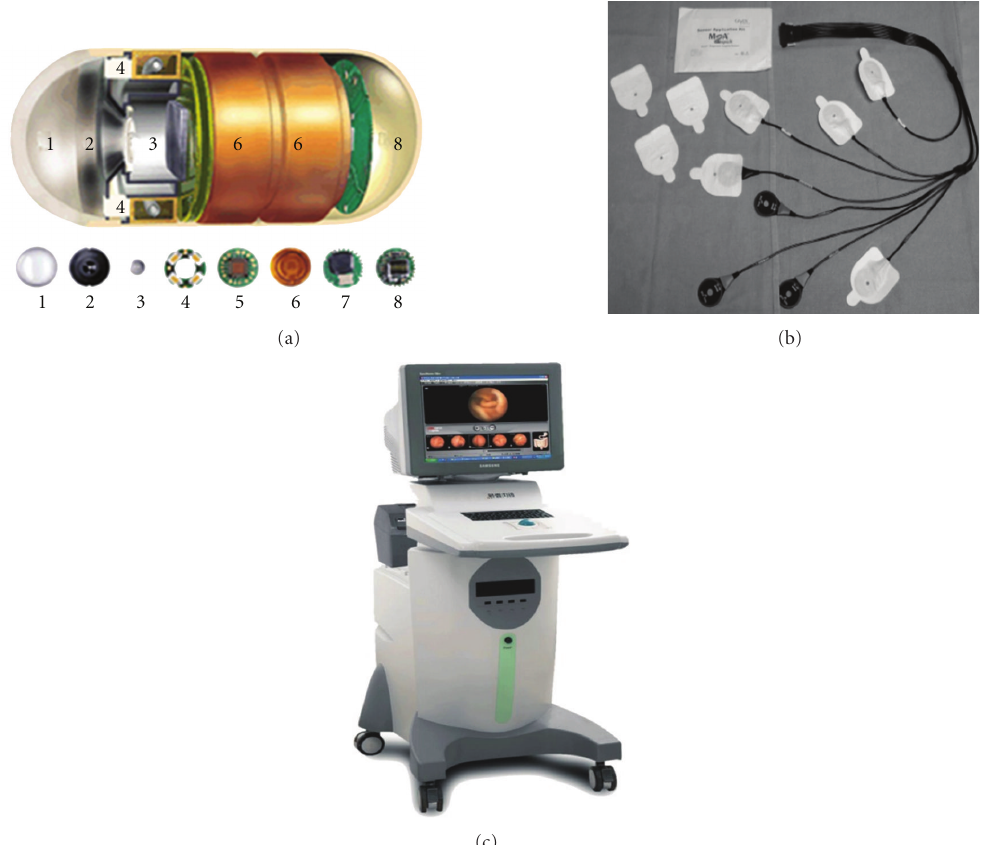
Figure 2: (a) Endoscopic capsule—1, Optical dome; 2, lens holder; 3, lens; 4, lEDs; 5, COMS imager; 6, battery; 7, ASIC transceiver; 8, antenna [25]. (b) Image recording unit [22]. (c) Workstation [26].